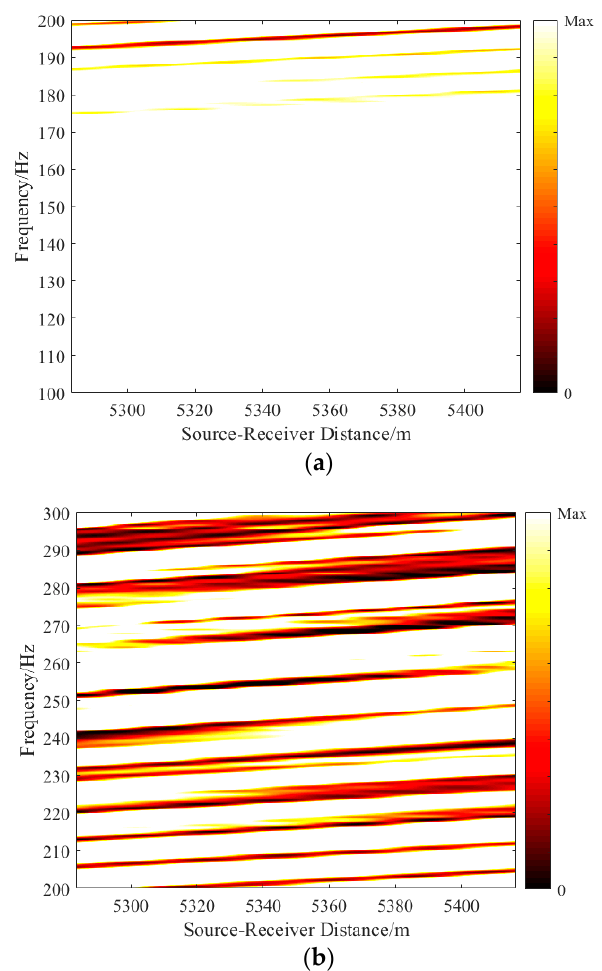
Figure 10. Sound intensity images corresponding to ( a ) 100–200 Hz and ( b ) 200–300 Hz frequency bands obtained based on inverted geoacoustic parameters.